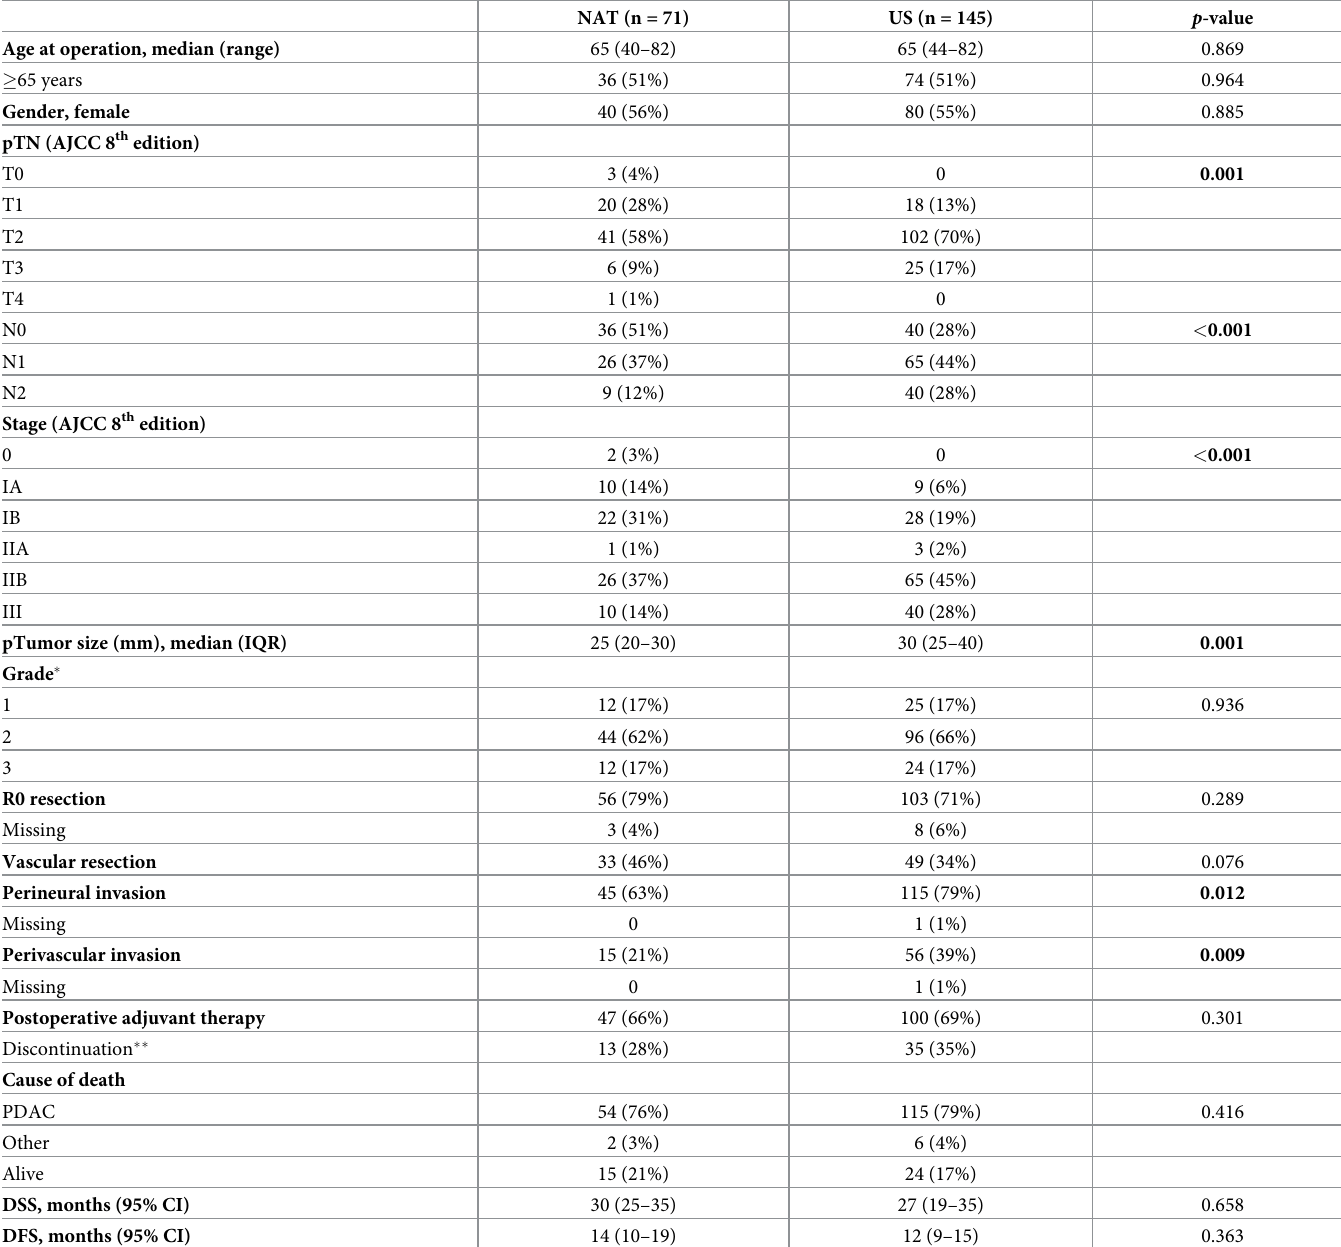
Table 1. Clinicopathological characteristics for NAT and US